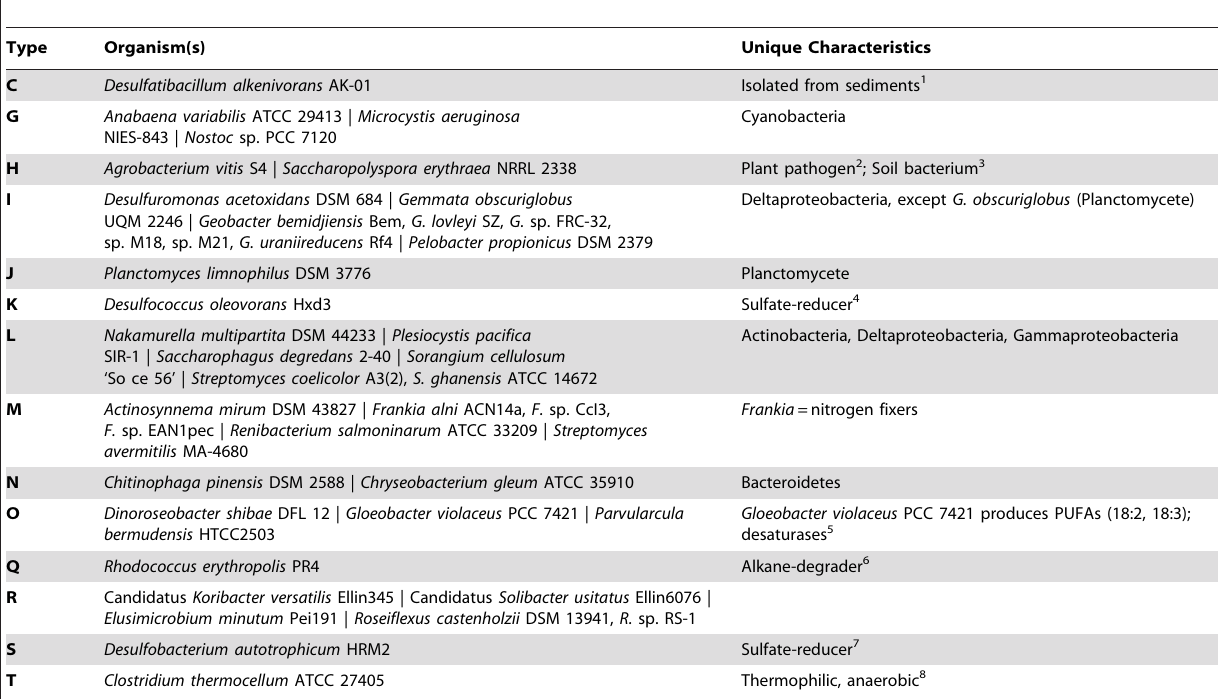
Table 2. Membership and description of secondary lipid synthase types with uncharacterized